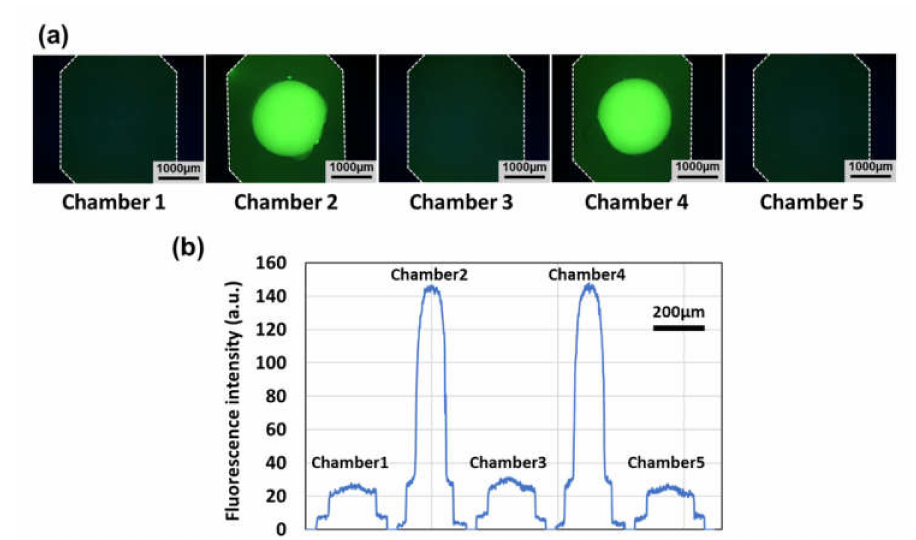
Figure 6. A comparison of the fluorescence intensity of two kinds of microchambers replicated with or without a hemispherical polymer bead. ( a ) Fluorescent microscopy images of microchambers (gain: 1 × , exposure time: 2 s). ( b ) Cross-sectional profiles of the fluorescence intensity across the center of each